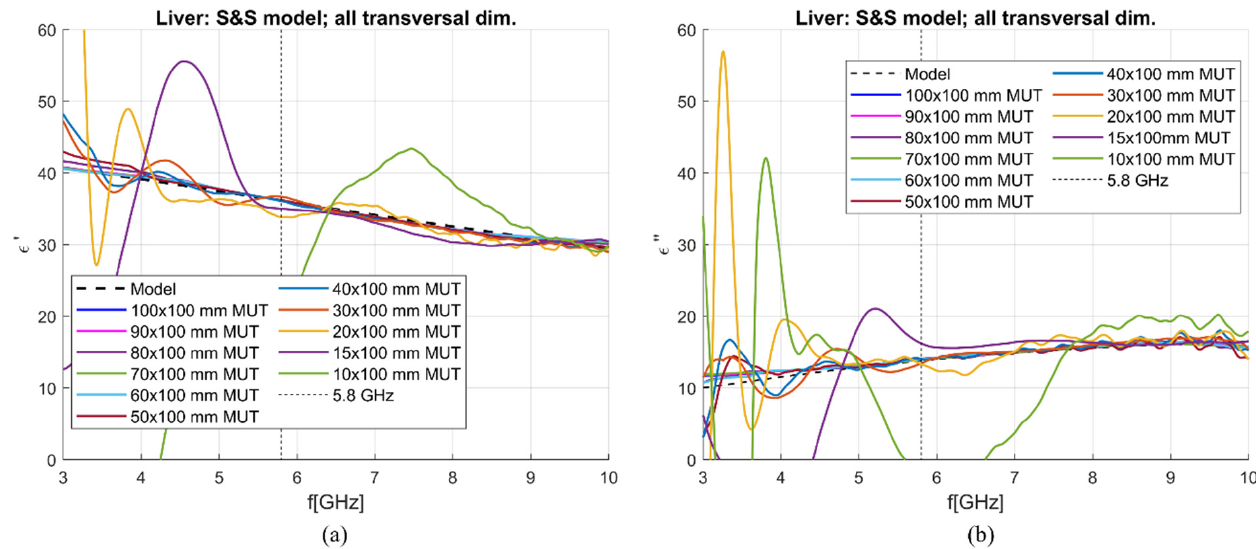
Figure 16. S&S de-embedding of liver simulated in different blocks: ( a ) Calculated vs. reference ε ’ (“real”); ( b ) calculated vs. reference ε ’’(“imag”). Table 5. Average sensitivity in the 5–6 GHz range and at 5.8 GHz for different sizes of MUT. Measurement Sensitivity